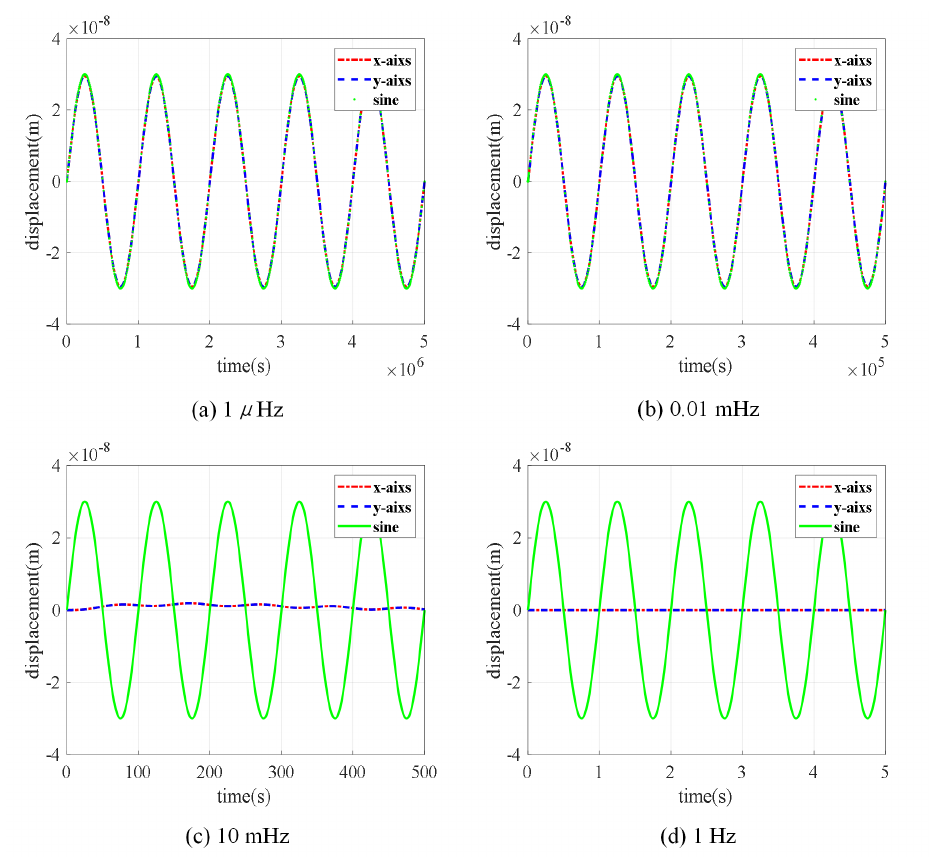
Figure 8. Tracking of sine signal for drag − free at ( a ) 1 µ Hz, ( b ) 0.01 mHz, ( c ) 10 mHz, ( d ) 1